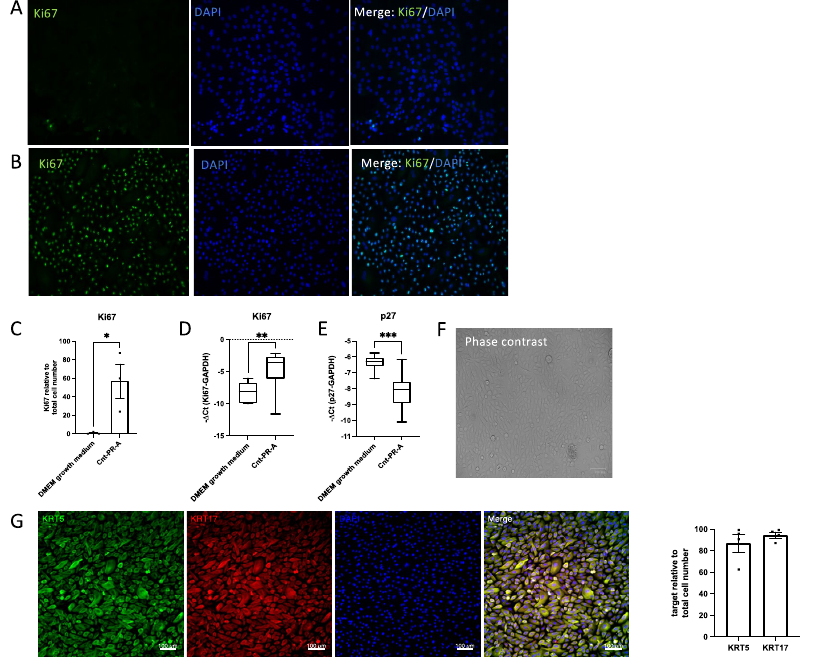
Figure 4. Alveolar basal cell proliferation in DMEM growth medium versus Cnt-PR-A. Representative Ki67 immunofluorescence (IF) stainings ( n = 3) of cells ( A ) cultured in DMEM growth medium for 5 days or ( B ) after medium change to Cnt-PR-A and culture for an additional 5 days. ( C ) Quantification of Ki67 IF stainings relative to total cell number (DAPI) in DMEM growth medium and Cnt-PR-A. Dots (•) in the bar chart represent the individual datapoints generated from cell stainings of three different patients. * indicates p < 0.05 (unpaired student’s t -test). ( D ) Ki67 or ( E ) p27 RNA expression comparing both culture conditions ( n = 12). TaqMan PCR data are expressed as − ∆ Ct. ** indicates p = 0.0017, *** indicates p = 0.0002 (unpaired student’s t -test). ( F ) Representative phase contrast image of alveolar basal cells in Cnt-PR-A, ( G ) Representative immunofluorescence images ( n = 4) and their quantification relative to the total cell number (DAPI) showing the expression of KRT17 and KRT5 in cells cultured in Cnt-PR-A. Dots (•) in the bar chart represent the individual datapoints generated from cell stainings of four different patients.